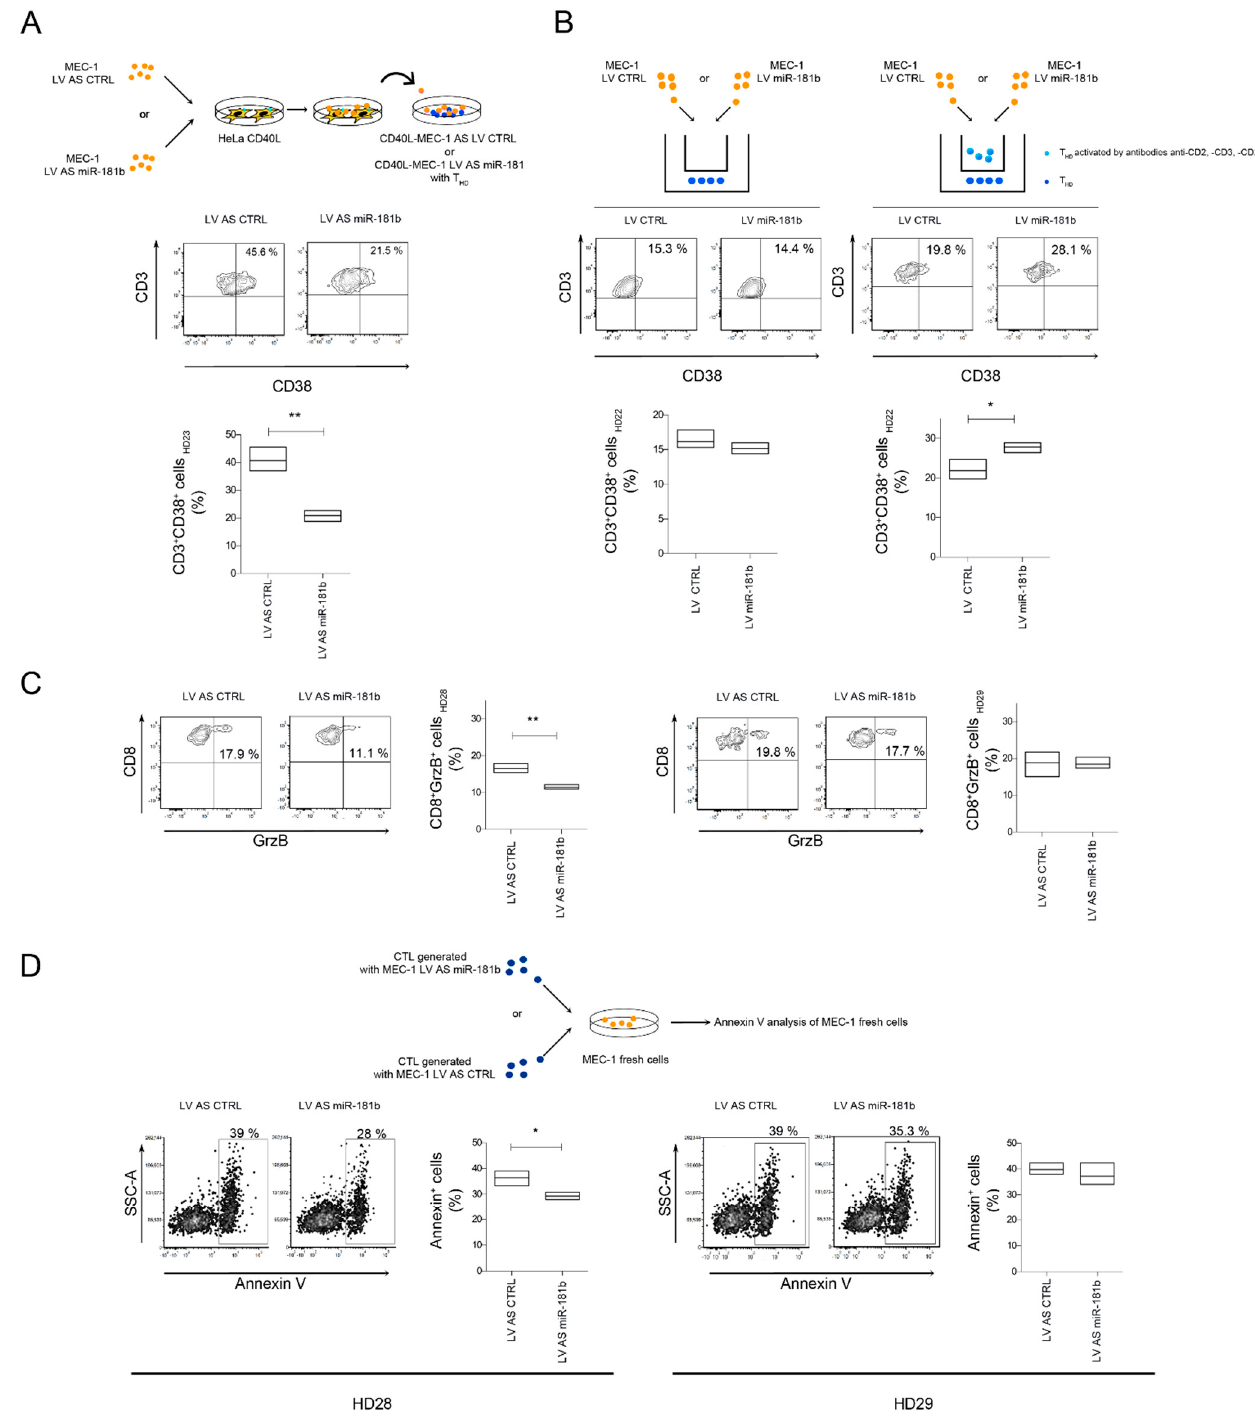
Figure 5. MiR-181b promotes the death of leukemia cells by inducing cytotoxic lymphocytes (CTL) maturation. ( A ) MEC-1 cells infected with either LV AS miR181b or LV AS CTRL were co-cultured with CD40L-HeLa. After three days, stimulated and transduced MEC-1 cells were mixed with CD3+ cells from healthy donor 23 (T HD23 ) to generate CTLs. Percentage of CD38+/CD3+ cells were measured after 8 days of co-culture. ( B ) MEC-1 cells infected with either LV miR-181b or LV CTRL were cultured with or without healthy activated T cells from healthy donor 22 (T HD22 ) (E/T ratio, 1:9) in the upper transwell chamber. In the lower chamber, T cells from the same healthy donors were seeded. After eight days, percentage of CD38+/CD3+ cells were measured in the lower transwell chamber. ( C ) Percentage of CD8+/GrZB+ cells from healthy donors 28 and 29 (T HD28 and T HD29 ) after generation of effector CTL assay as described in B. ( D ) Percentage of fresh VPD+/AnnV+ MEC-1 cells co-cultured for 1 h with CTLs generated in D; E/T ratio, 2:1. Data ( A – D ) are reported as floating bars (min to max) with the central line marking the mean of experimental triplicates. p -values were calculated by Student’s t test (* p < 0.05, ** p <